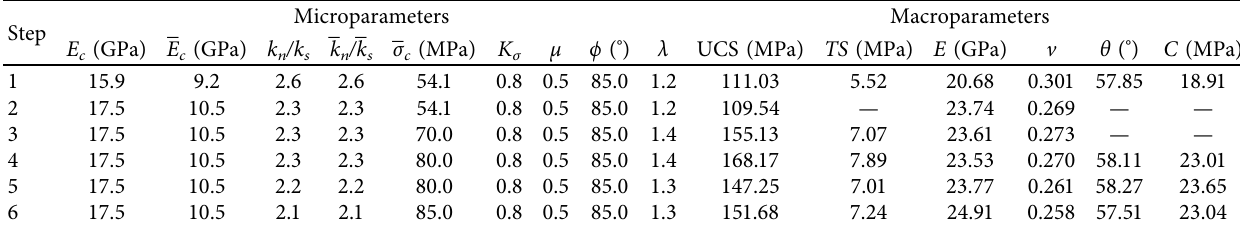
Table 6: Process of dolomite microparameter calibration.